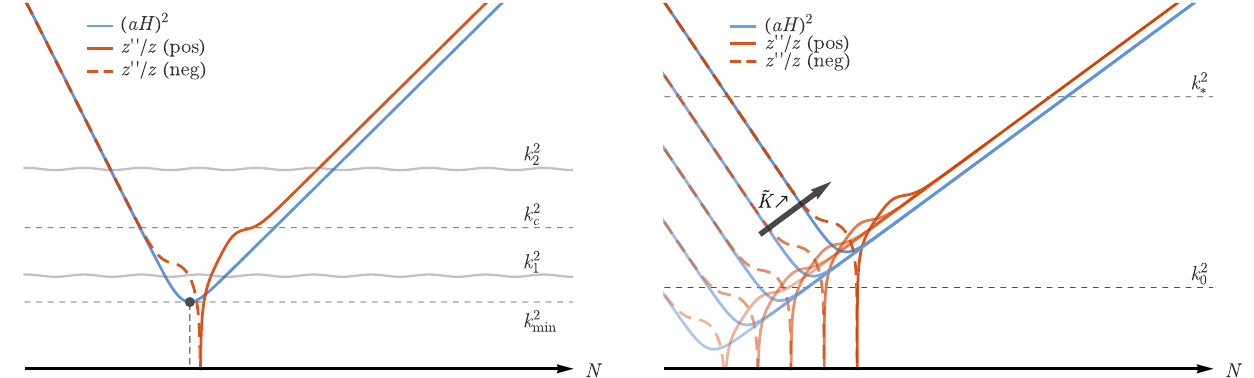
Fig. 2 (Left Panel) The shape of the potential z (cid:10)(cid:10) / z (red) and ( aH ) 2 (blue) around the transition from decelerated expansion to power-law inflation. The imprints of the transition on the primordial power spec- trum are expected on modes with wave-number k 1 (cid:3) k c where k c is a characteristic scale defined by the features (bumps) of the potential during the transition. For k 2 (cid:13) k c the modes should be “blind” to the shape of the potential during inflation and the usual shape of P R should be recovered. The moment of transition from decelerated expansion to